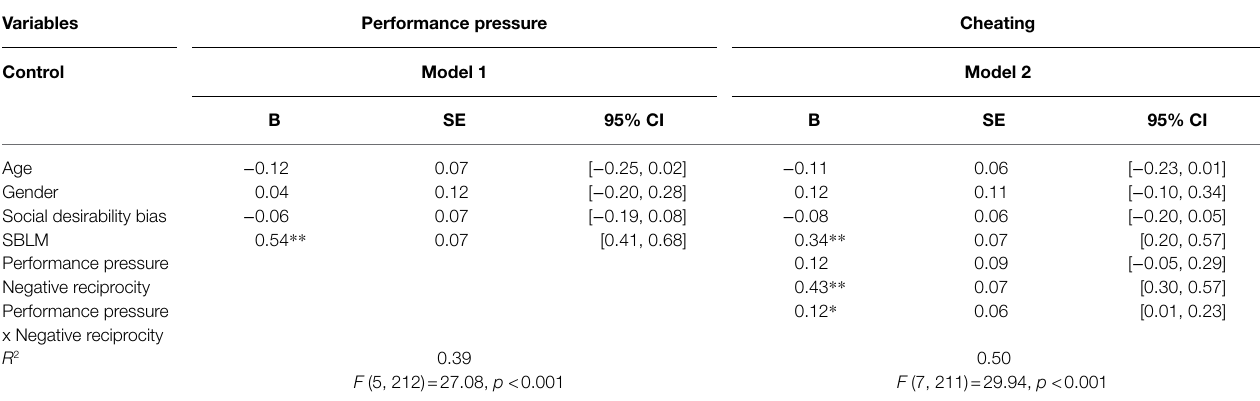
TABLE 7 | Regression results for performance pressure and cheating (Study 2). Variables